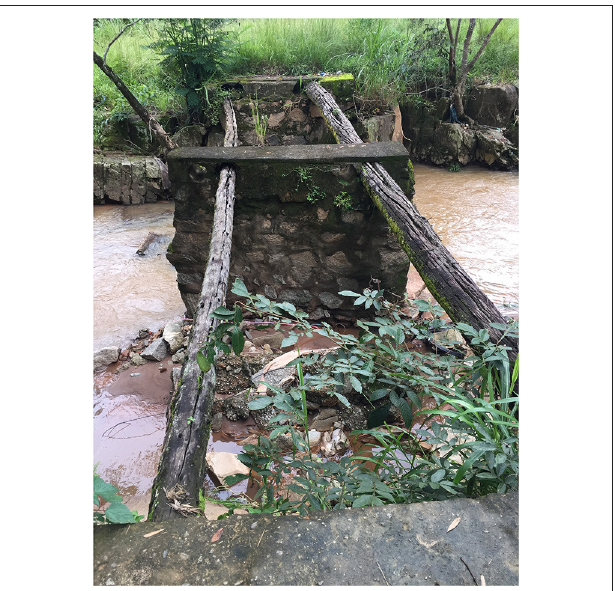
FIGURE 3 | Old bridge crossing the Ribeirão Vermelho in front of the Madeira farm. Source: Sousa R. B. et al.